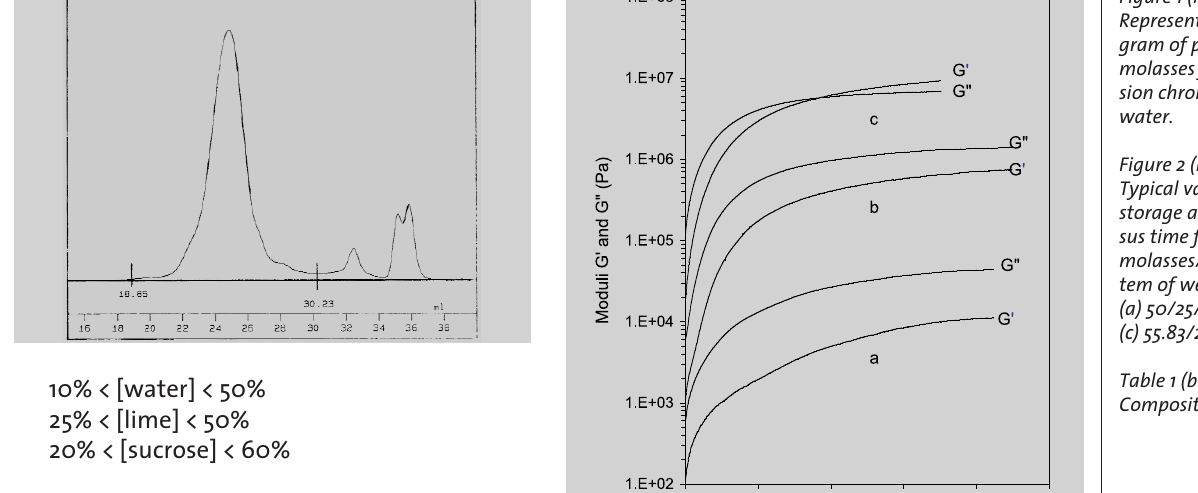
Figure 1 (left): Representative chromato- gram of polysaccharides in molasses from a size exclu- sion chromatography in water. Figure 2 (right): Typical variations of the storage and loss moduli ver- sus time for molasses/lime/water sys- tem of weight composition (a) 50/25/25, (b) 52/26/22, (c) 55.83/27.91/16.25. Table 1 (bottom): Composition of